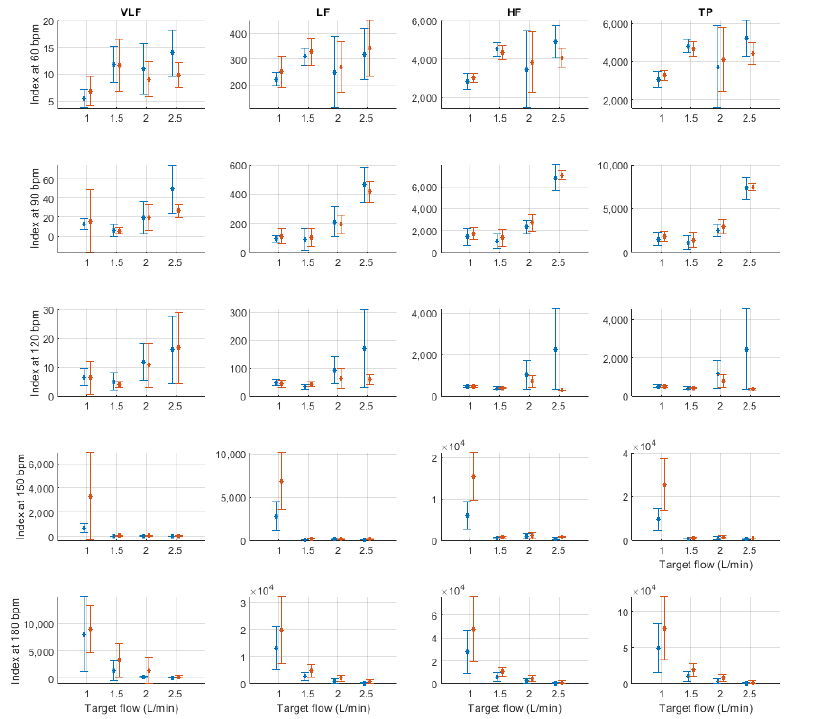
Figure A6. Mean and standard deviation of absolute frequency-domain indices extracted from pulse rate variability under different stroke rates (SR) and target flows (TF, TF below 2.5 L/min) conditions, and measured from the radial (blue) and deep palmar arch (orange)